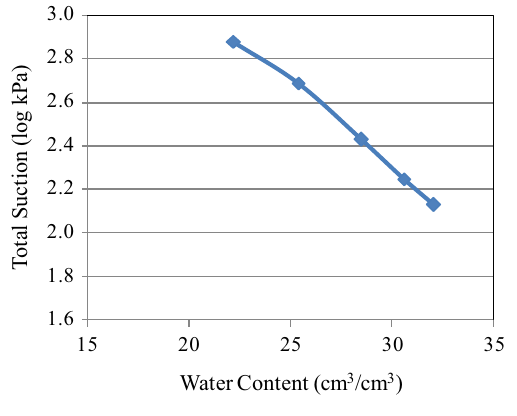
Fig. 3 Moisture content versus total suction